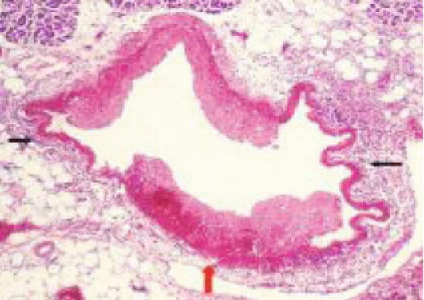
Figure 13: Segmental arterial mediolysis injurious phase. The red arrow points to a medial island, situated between two fi brin-lined gaps (black arrows), showing early detachment provoked by hemorrhage from injured granulation tissue in the outer media and adventitial-medial junction. Hematoxylin & eosin × 100 (adapted with permission from the International Journal of Surgical Pathology 15(2) copyright 200, Sage Publications, Inc.).